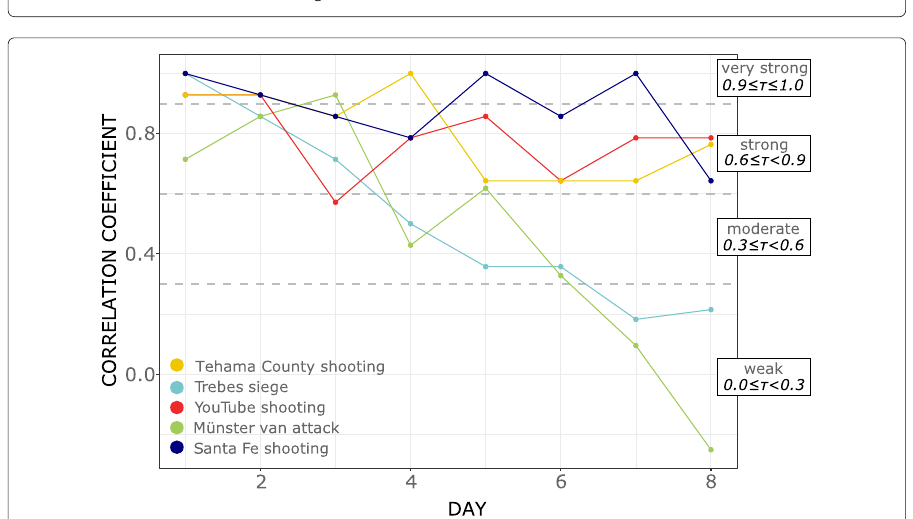
Fig. 7 Temporal volatility of the correlation coefficient between the emotion intensity communicated directly between a pair of users and the overall intensity of emotions per